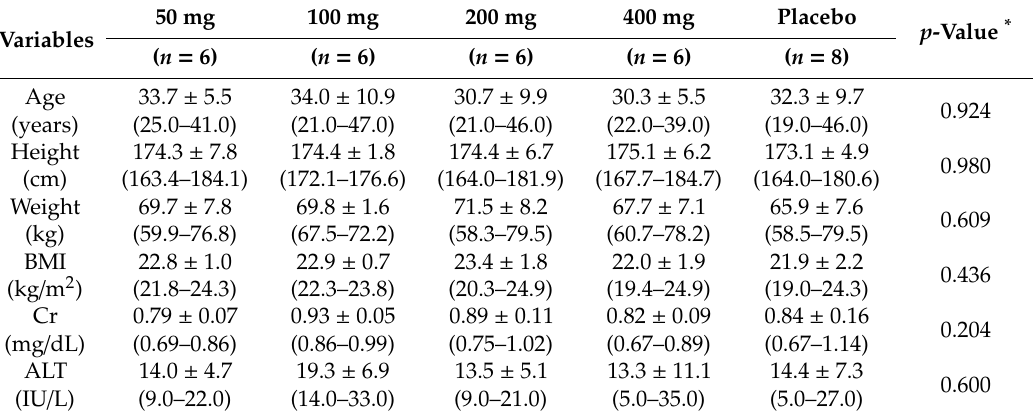
Table 1. Demographic characteristics of subjects at